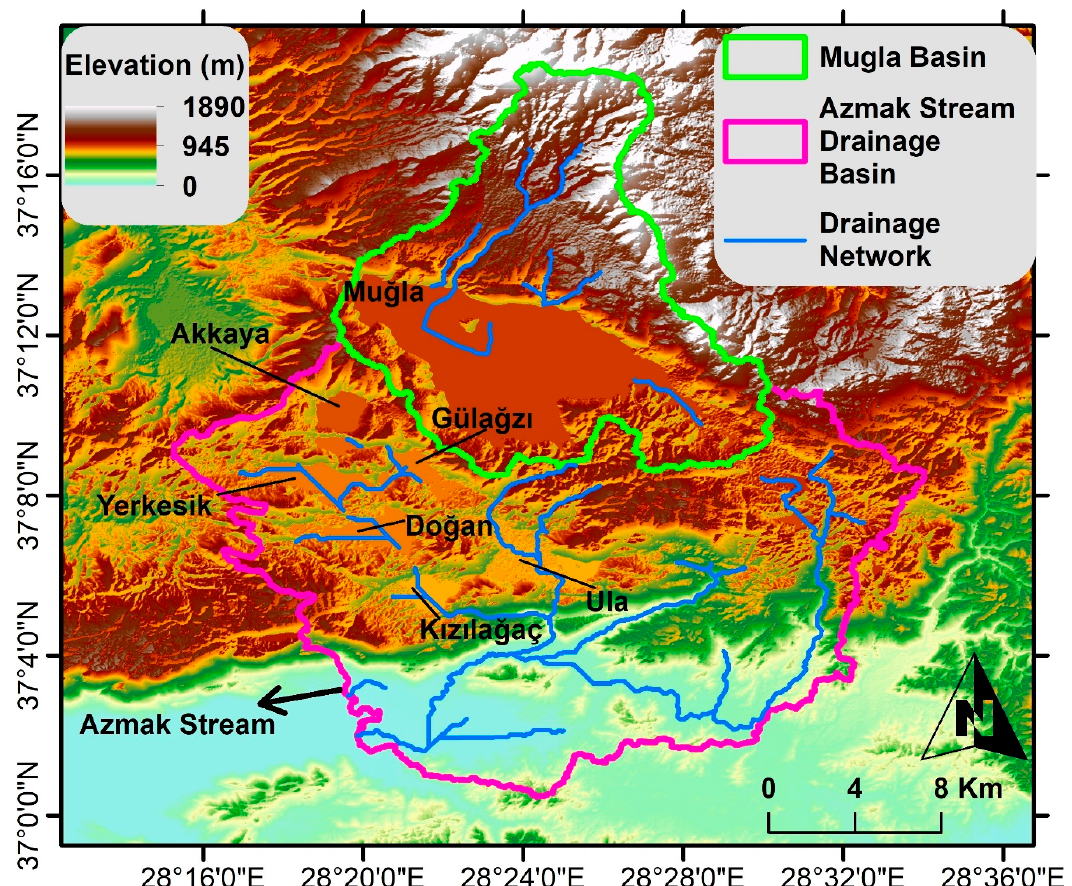
Figure 2. The drainage basin of the Azmak Stream including the Mugla basin.